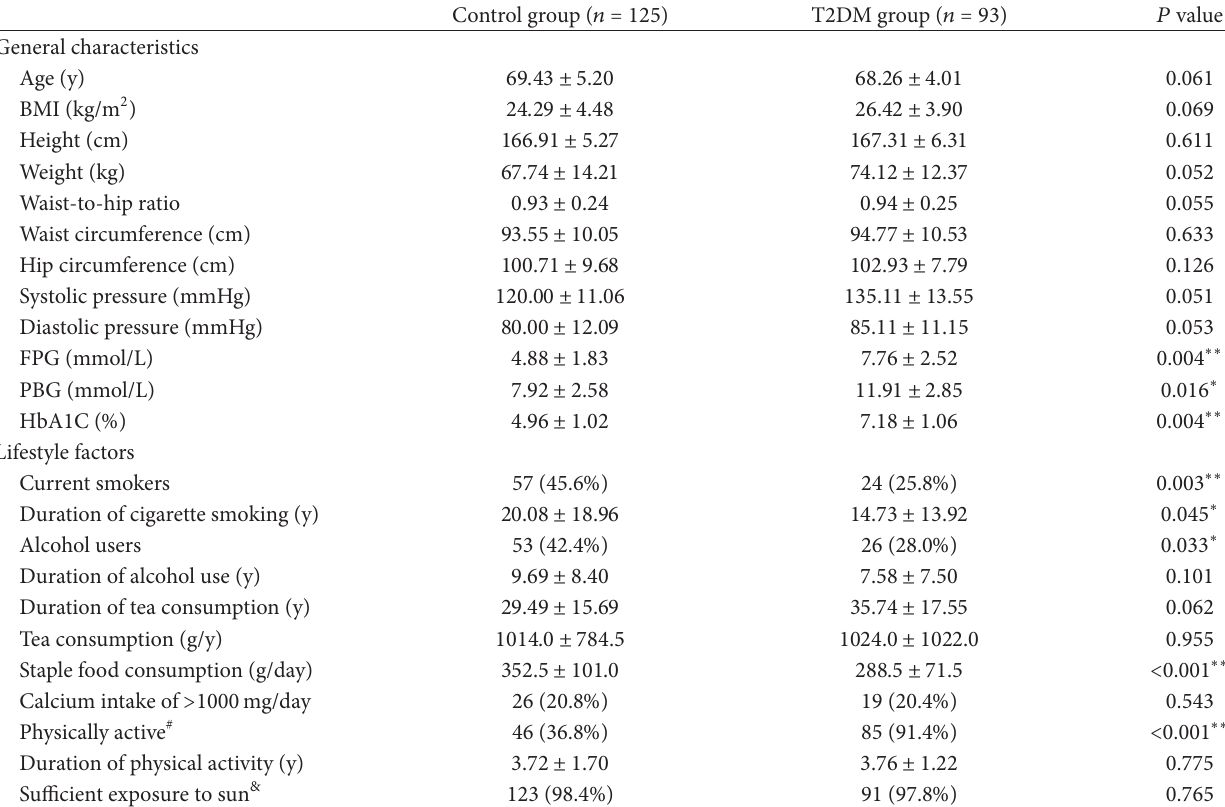
T 1: General characteristics of patients with T2DM and the control subjects. Control group ( 𝑛𝑛 =